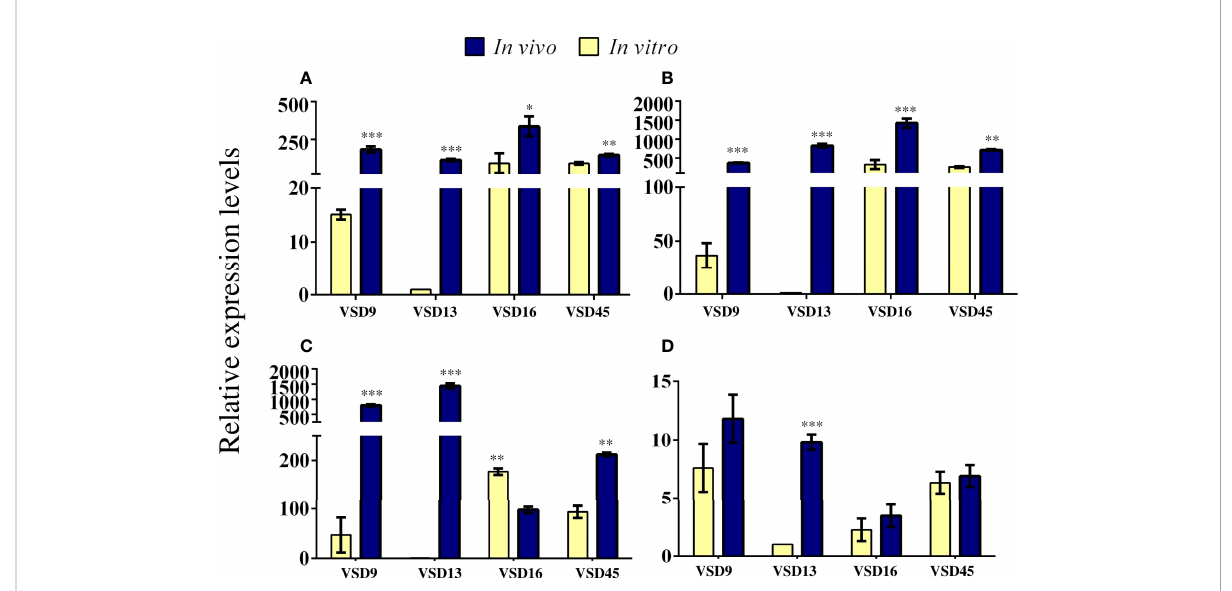
FIGURE 6 Relative expression levels of (A) brpA -like (B) fbpA (C) htrA and (D) sagA genes in sessile cells generated in vivo compared with those formed in vitro . RT-qPCR was expressed as the mean of three biologically independent experiments. The bar represents the standard deviation. The calibration sample was the cDNA for VSD13 bio fi lm grown in vitro . Statistically signi fi cant differences were observed for gene expression in SDSD bio fi lm grown in vivo or in vitro : * p < 0.05; ** p < 0.01; *** p <